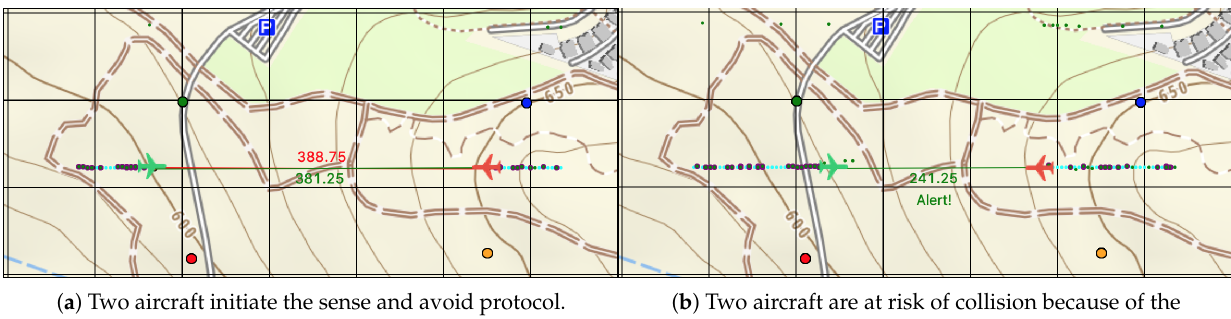
( a ) Two aircraft initiate the sense and avoid protocol. ( b ) Two aircraft are at risk of collision because of the short distance between them. Figure 7. The large-scale simulator built for this study. These images display a simulation of the sense and avoid protocol for two aircraft.